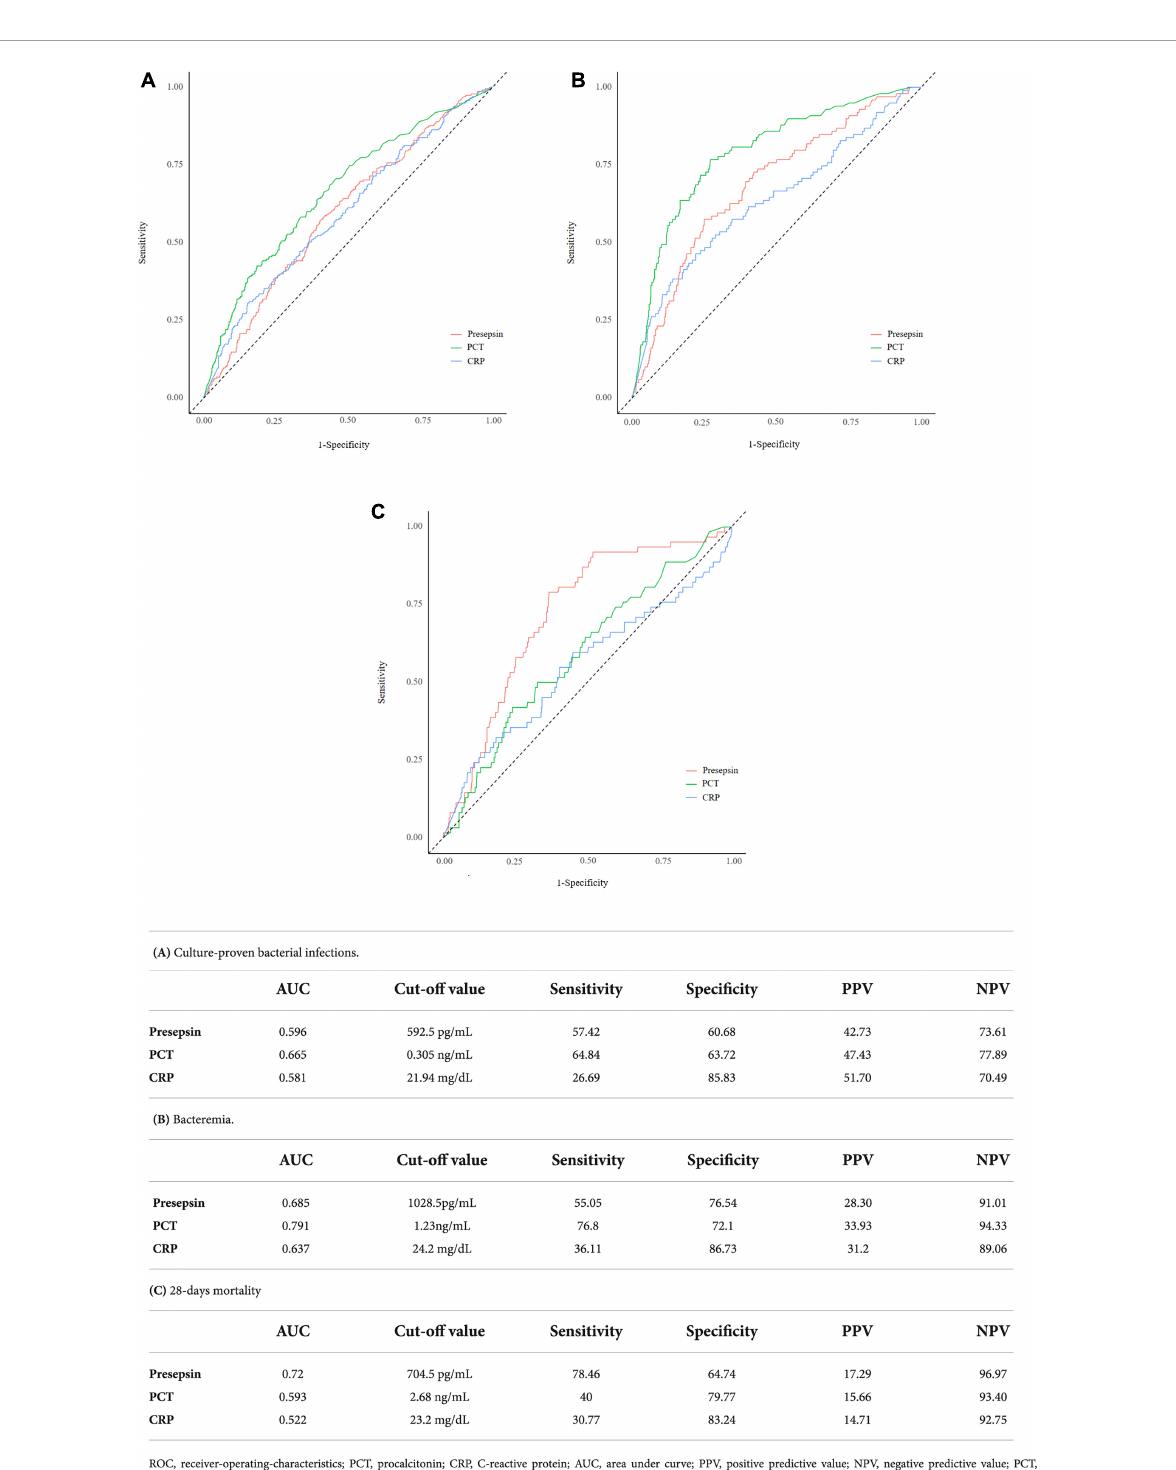
FIGURE1 ROC curves for predicting culture proven bacterial infections, bacteremia, and 28-day mortality along with sensitivity, specificity, positive predictive value (PPV), and negative predictive value (NPV) at the best cut-offs for the following parameters: presepsin, PCT, and